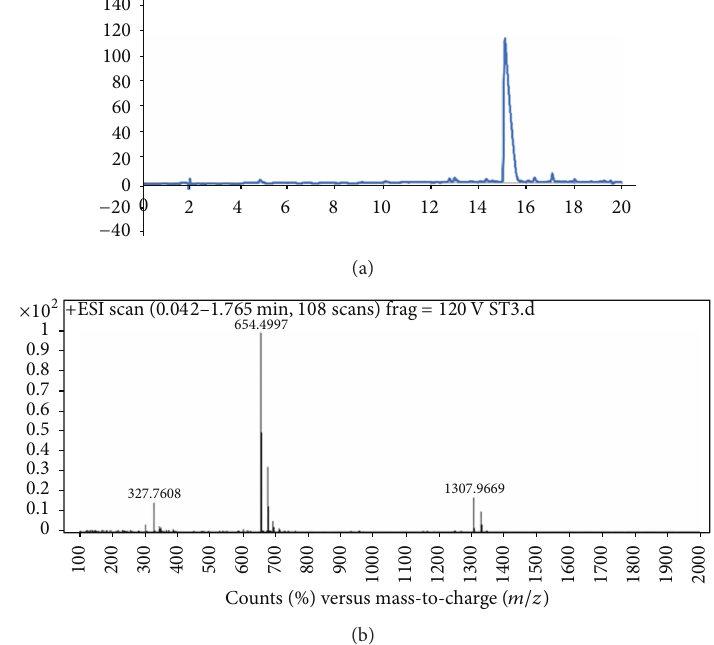
Figure 1: Liquid chromatography (a) and mass spectrometry (b) characterization of the peptide amphiphile (PA) molecule.